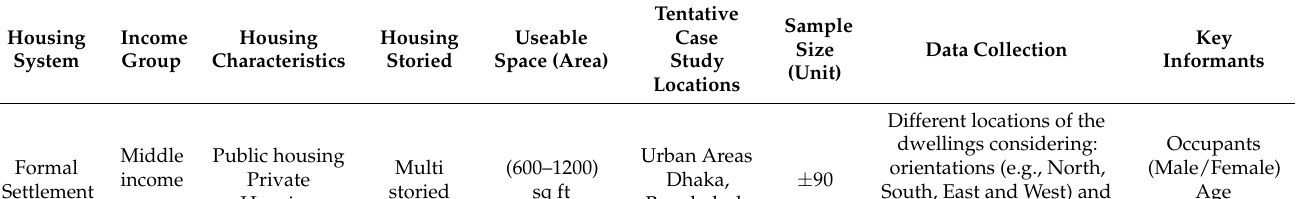
Table 1. Information of field data collection.